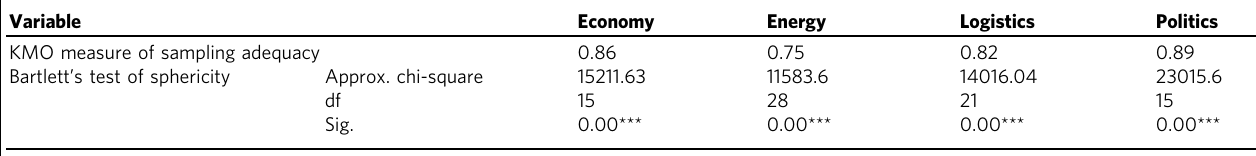
Table 3 KMO values and Bartlett ’ s tests results.